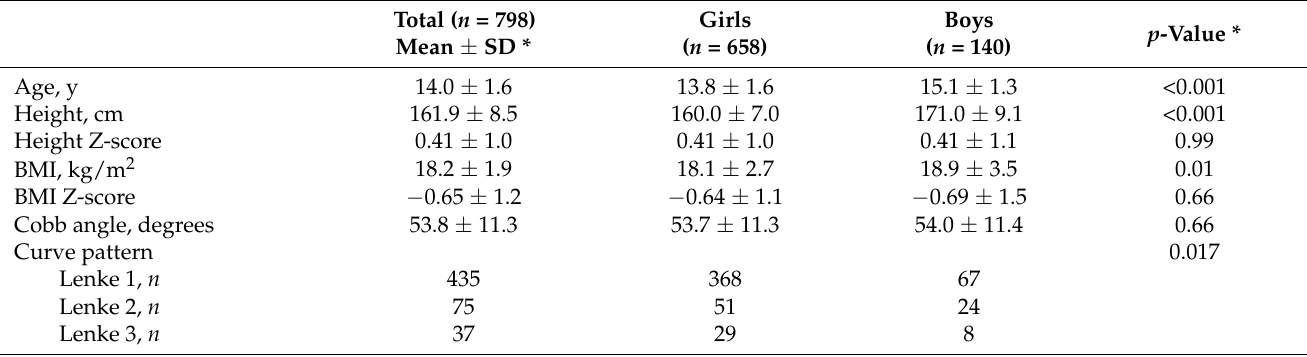
Table 1. Demographic data and information of bone mineral density in girl and boy AIS